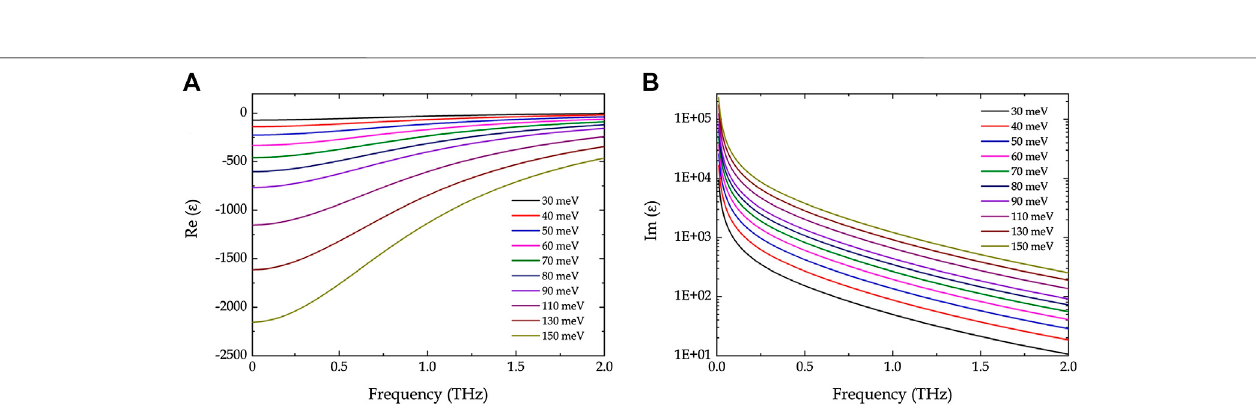
FIGURE3|(A) Real and (B) imaginaryparts oftheDiracsemimetal fi lm(DSF) dielectric functionsunderdifferentFermilevels. The parameters ofthe DSFareset as g (cid:2) 4, ε b (cid:2) 12, ε c (cid:2) 3, µ (cid:2) 3*10 4 cm 2 V − 1 S − 1 .